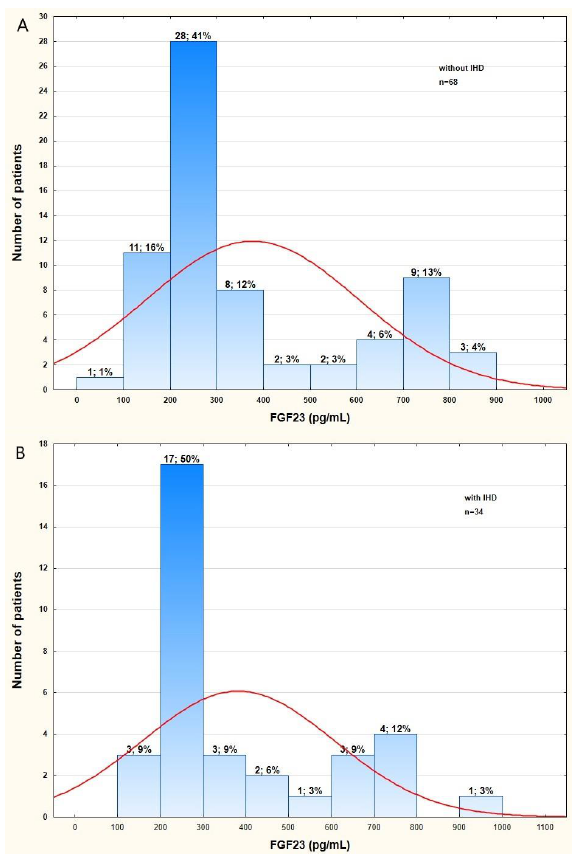
Figure 2. The distribution of FGF23 levels in patients with long-standing type 2 diabetes mellitus according to IHD status ( A , B ). Abbreviations: FGF23, fibroblast growth factor 23; IHD, ischemic heart disease.